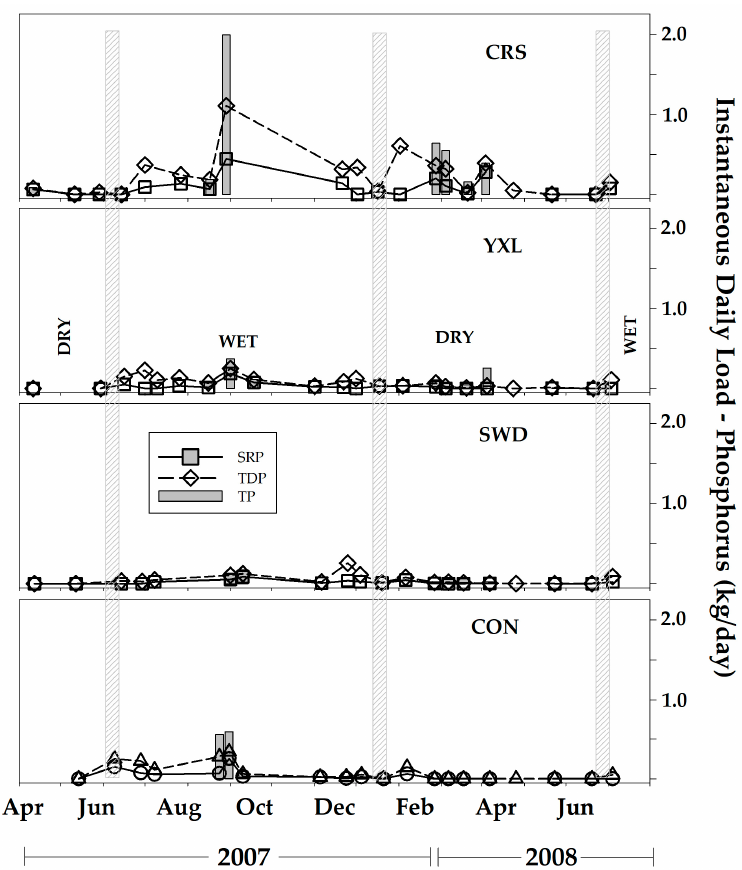
Figure 7 Daily phosphorus fluxes from the study catchments. Figure 7. Daily phosphorus fluxes from the study